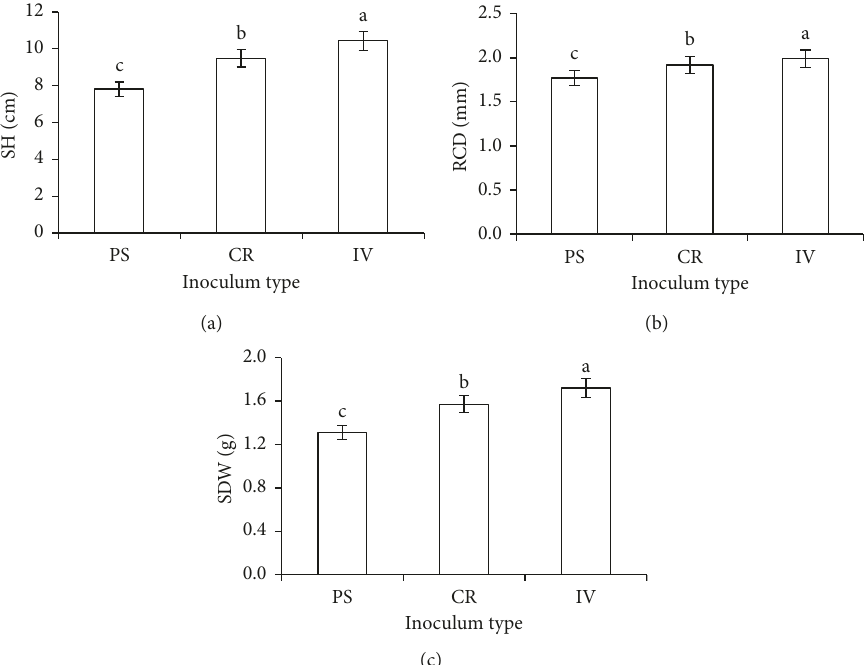
Figure 3: (a) Shoot height (SH), (b) root collar diameter (RCD), and (c) shoot dry weight (SDW) of P. maximinoi seedlings as a function of inoculum type. Bars indicate standard error. Columns with different letters indicate significant difference ( P ≤ 0 . 05) according to the multiple range test of